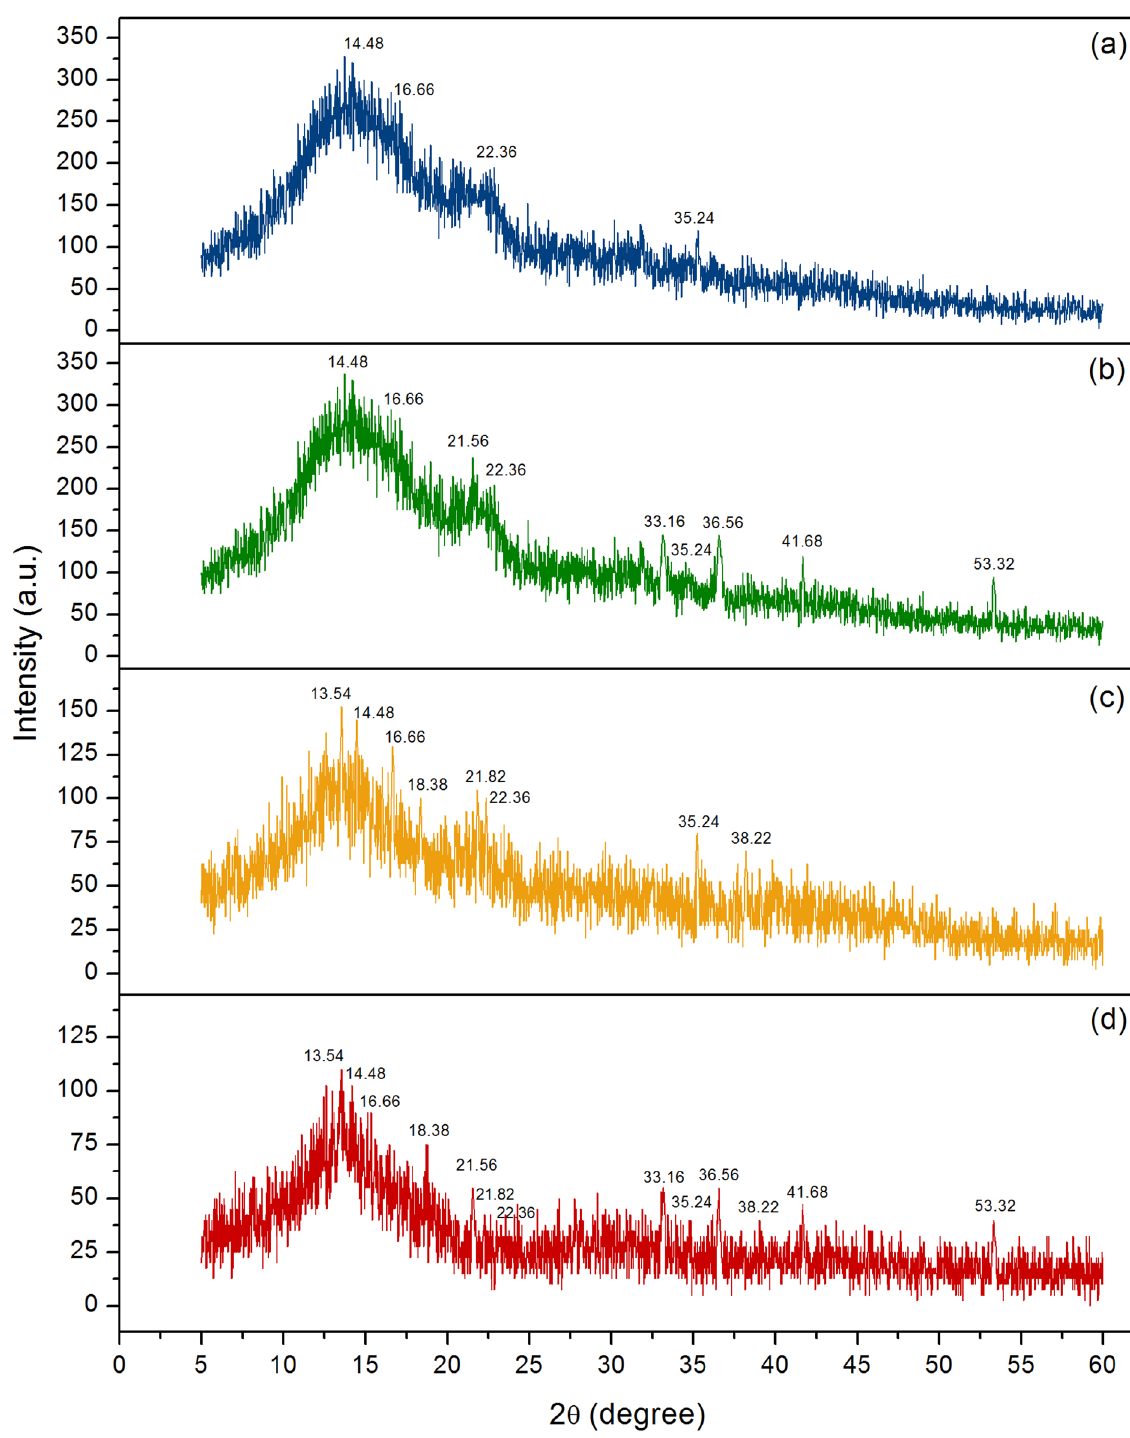
Figure 2. The crystalline patterns of ( a ) sugarcane bagasse powder (SB), ( b ) sugarcane bagasse powder doped iron(III) oxide-hydroxide (SBF), ( c ) sugarcane bagasse powder beads (SBB), and ( d ) sugarcane bagasse powder doped iron(III) oxide-hydroxide beads (SBFB) by XRD